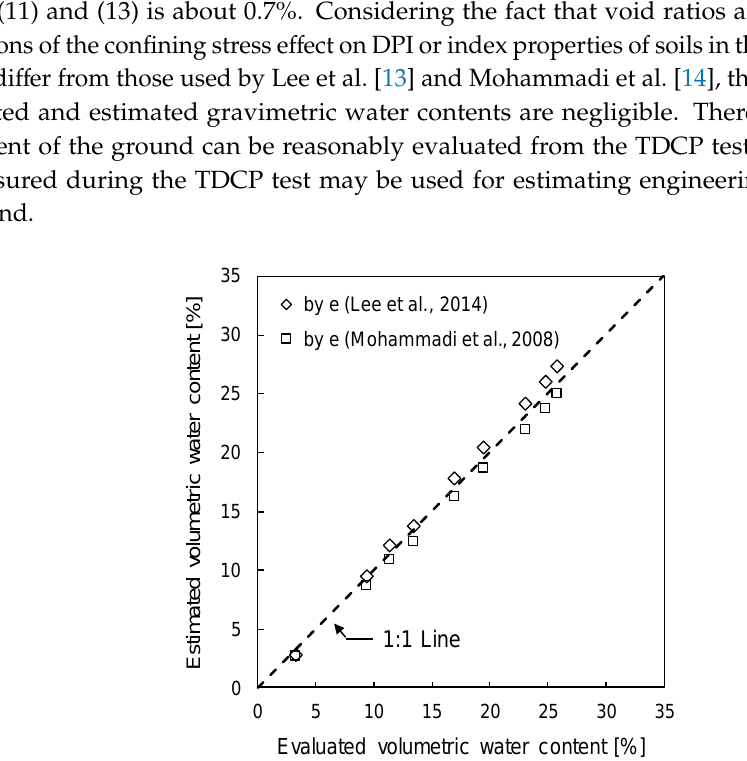
Figure 16. Comparison of the evaluated and estimated volumetric water contents.